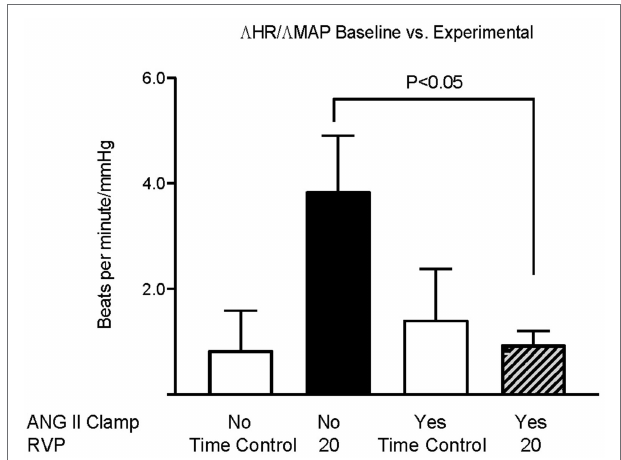
FIGURE 2 | Changes in HR per changes in MAP in untreated rats and ANG II Clamp rats. The ratio of the change in heart rate vs. the change in MAP of the baseline measurements vs. the measurements at 90 and 120 min was calculated for each animal. Groups, untreated Time Controls (TC, n = 9), untreated animals subjected to increased RVP ( n = 8), ANG II Clamp time controls (not subjected to an increase in RVP, n = 8), and ANG II Clamp animals subjected to increased RVP ( n = 10) were compared using two-way ANOVA with Bonferroni